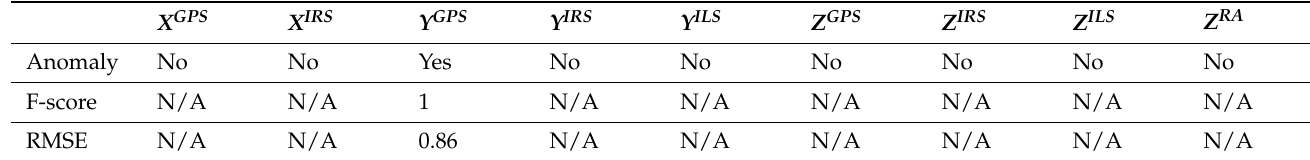
Figure 29. Drift anomaly detected and corrected on a specific landing using NADCA. Table 5. Result for each signal after using